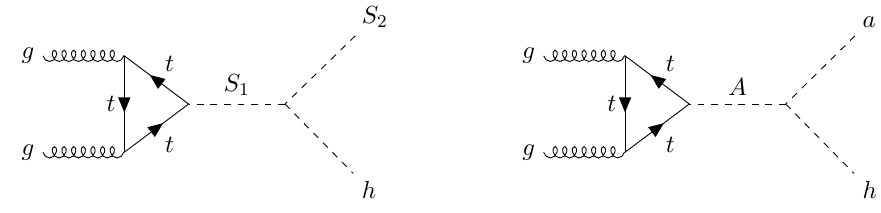
Figure 12 . Feynman diagrams for the resonant production of a mono- h signal via gluon fusion production in the chosen mass hierarchy for the 2HDM+S (left) and 2HDM+PS (right).